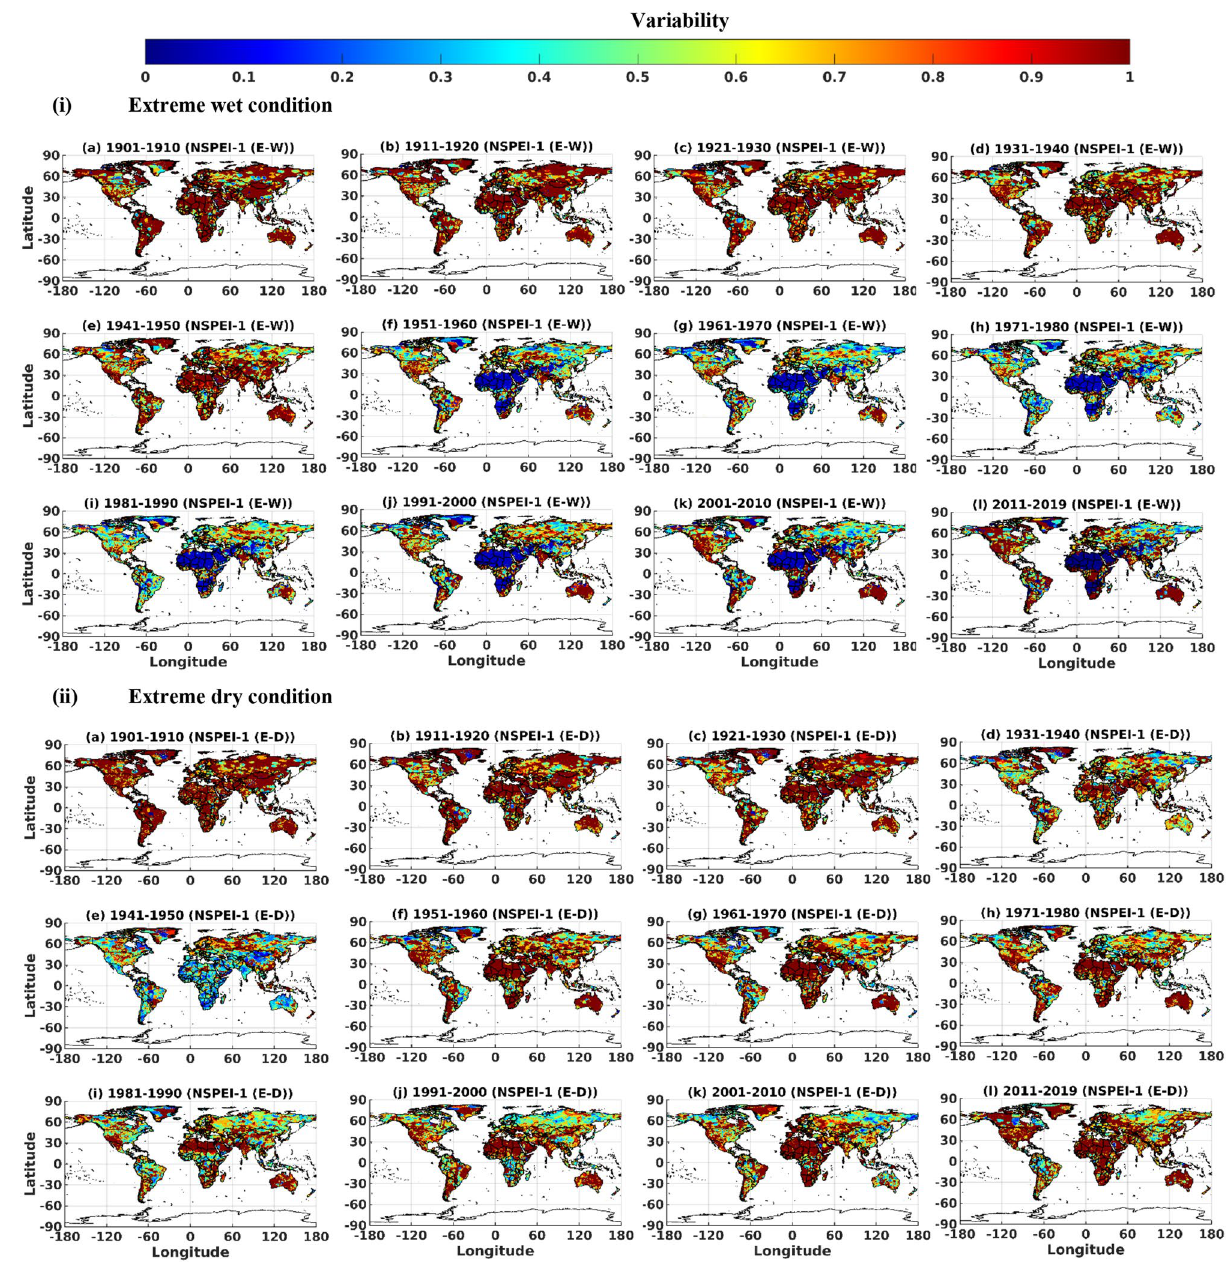
Figure 8. Decadal scale variability (SVI DE ) of extreme (i) wet (E-W) and dry (E-D) conditions for 1-month accumulation period (AP). *The maps were generated using MATLAB (version: